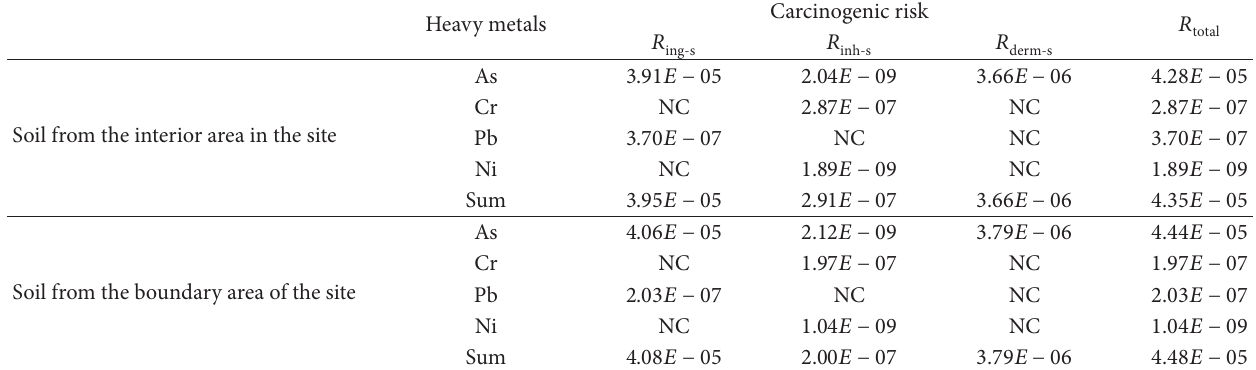
Table 8: Individual carcinogenic risk of carcinogens in the